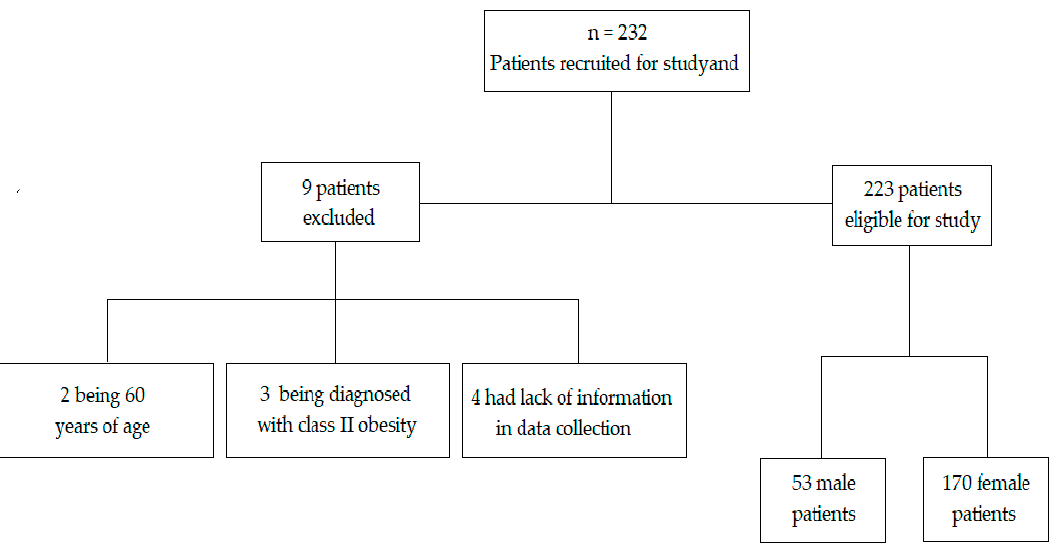
Figure 1. Flow chart of the study.